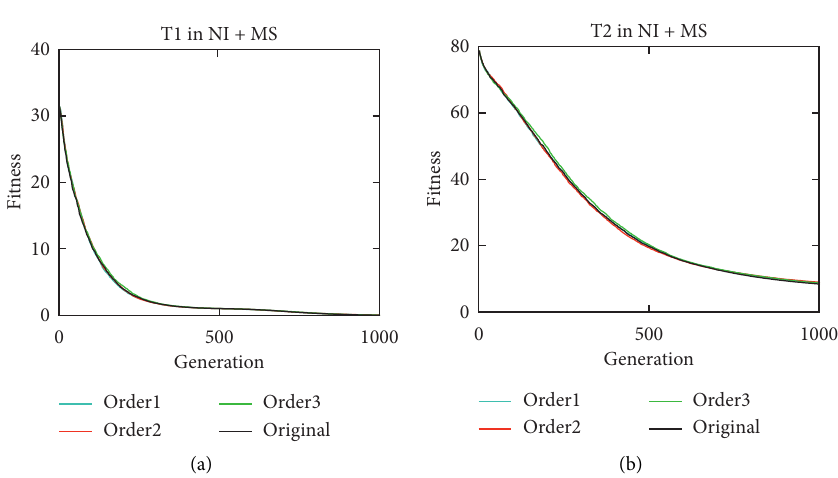
Figure 20: Convergence of MFDE for problem 8 (NI +MS).